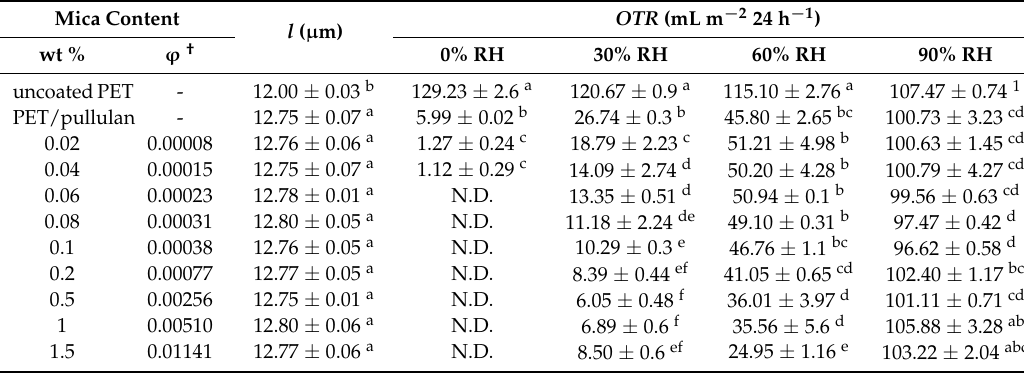
Table 1. Oxygen transmission rate ( OTR ) of uncoated poly(ethylene terephthalate) (PET) and coated PET and bionanocomposite coatings at 0%, 30%, 60%, and 90% relative humidity (RH) for the different filler volume fraction ( ϕ